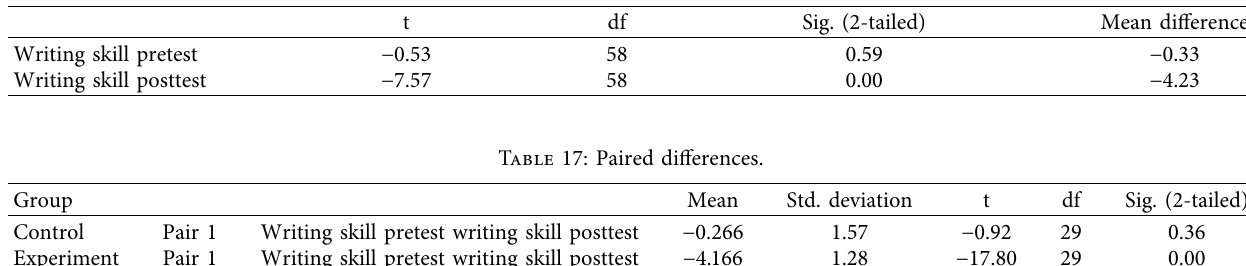
Table 16: Independent-sample test.